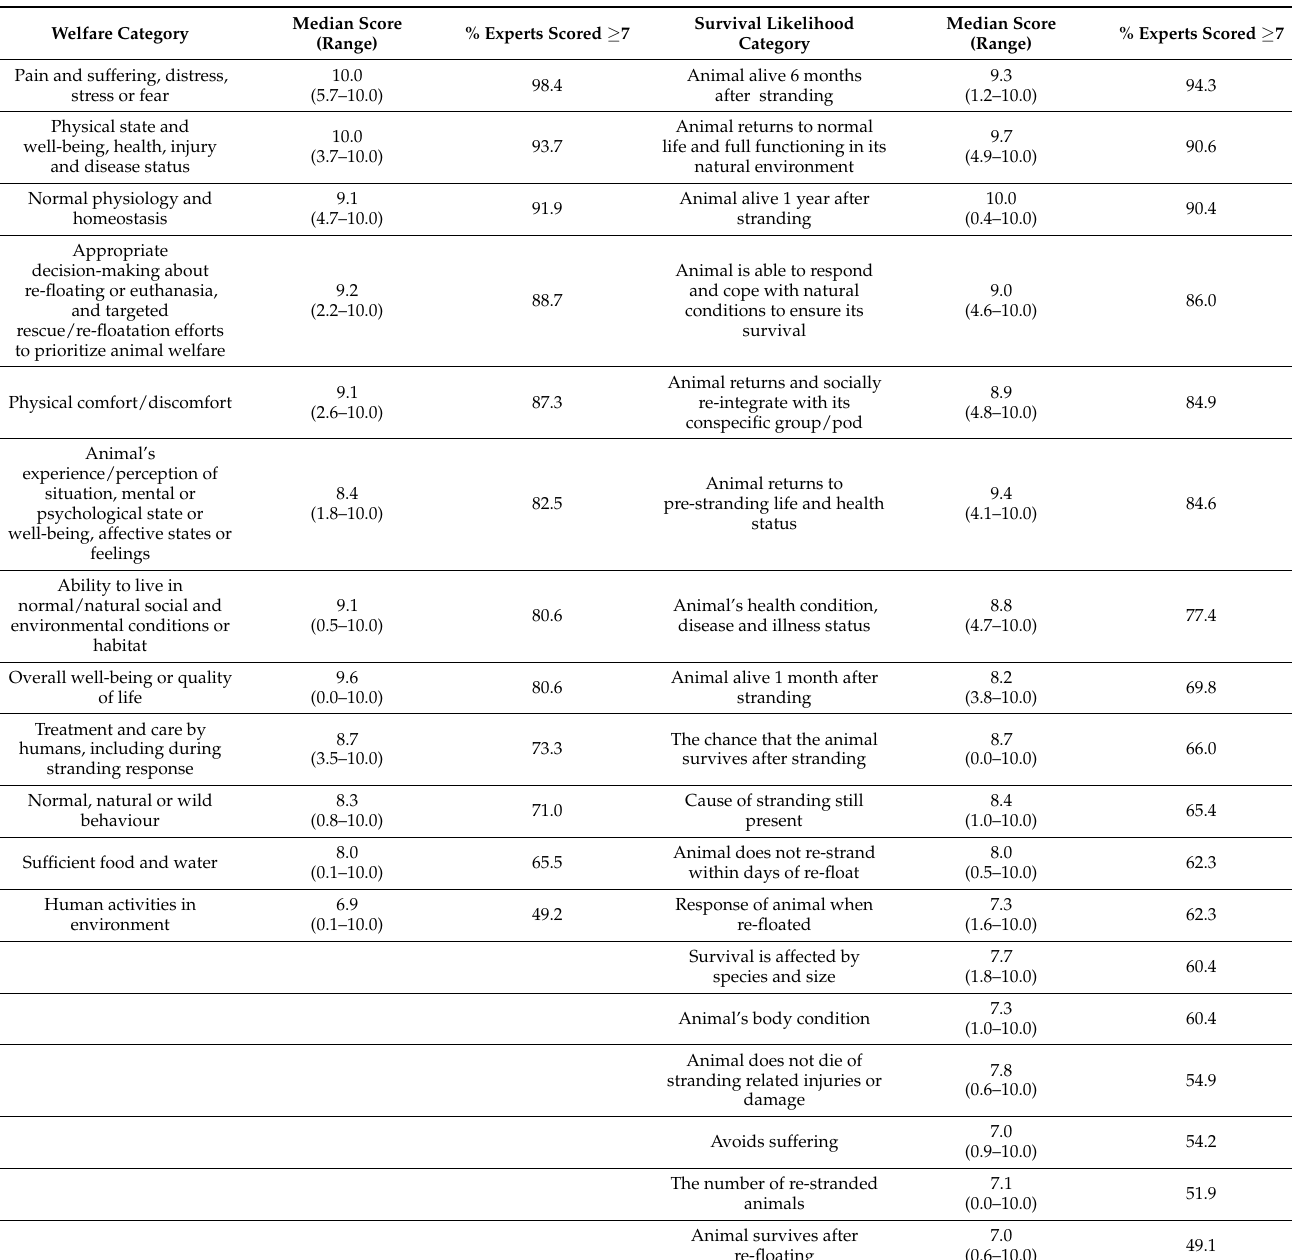
Table 1. The major categories for characterising the concepts of welfare and survival likelihood arising from reflexive thematic analysis of participant responses to questionnaire 1, and median score and range for each category from questionnaire 2. Categories are ranked by the percentage of experts that scored them as having great importance for characterising the concepts (score in ≥ 7 grouping). Those categories above the bold line reached consensus ( ≥